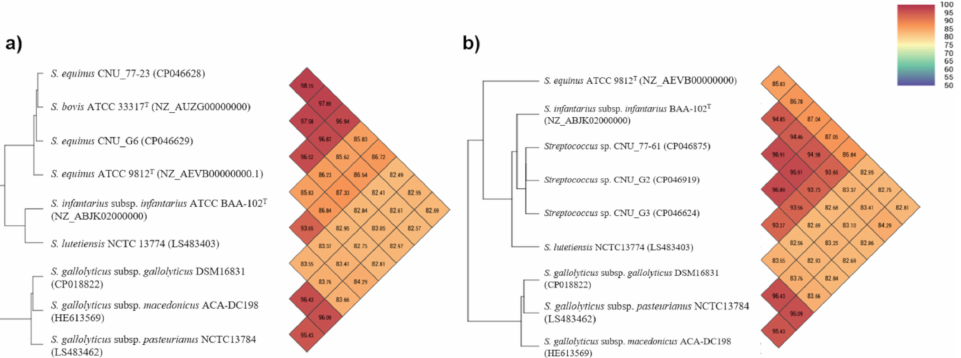
Figure 2. Overall genome relatedness and heatmaps generated with the OrthoANI values calculated using the complete sequenced genomes of S. equinus strains CNU_77-23 and CNU_G6 ( a ) and the other three SBSEC strains CNU_77-61, CNU_G2, and CNU_G3 ( b ) compared with other sequenced genomes of SBSEC strains available in the GenBank database. The results of each two-strain com- parison are given where the diagonals departing from each strain meet, e.g., the OrthoANI value between S. equinus CNU_77-23 and S. bovis ATCC 33317 T is 97.85%. (2-column fitting